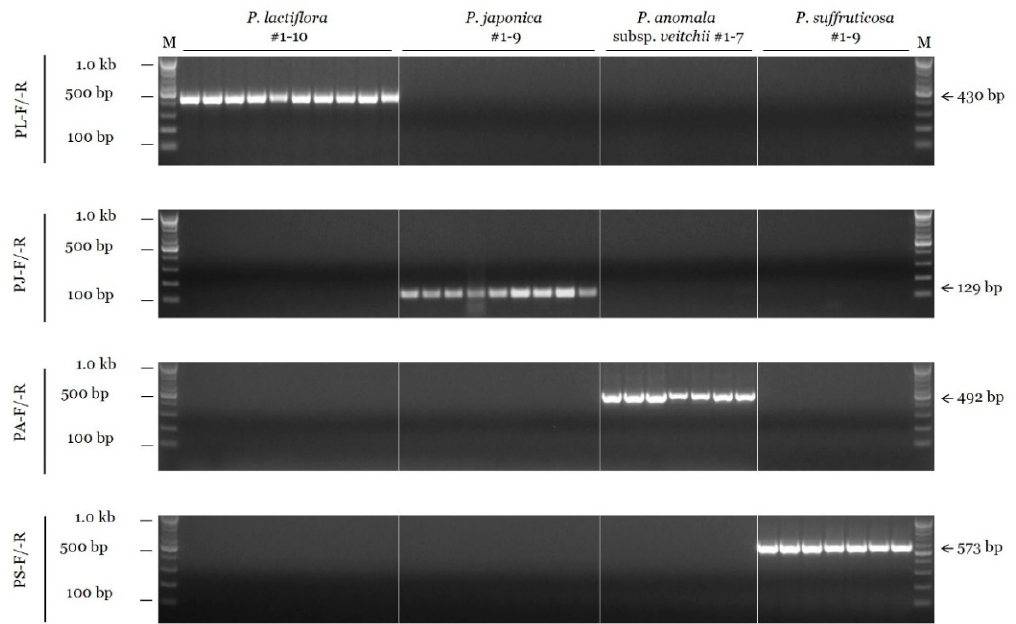
Figure 1. Specificity of the SCAR primers using the conventional PCR assay. SCAR primer combi- nations (PL-F/-R, PJ-F/-R, PA-F/-R, and PS-F/-R) are shown on the left. ‘M’ indicates the 100 bp DNA ladder, and the sizes of different bands (100 bp, 500 bp, and 1.0 kb) are indicated on the left. Arrows and numbers on the right indicate the amplicon size.